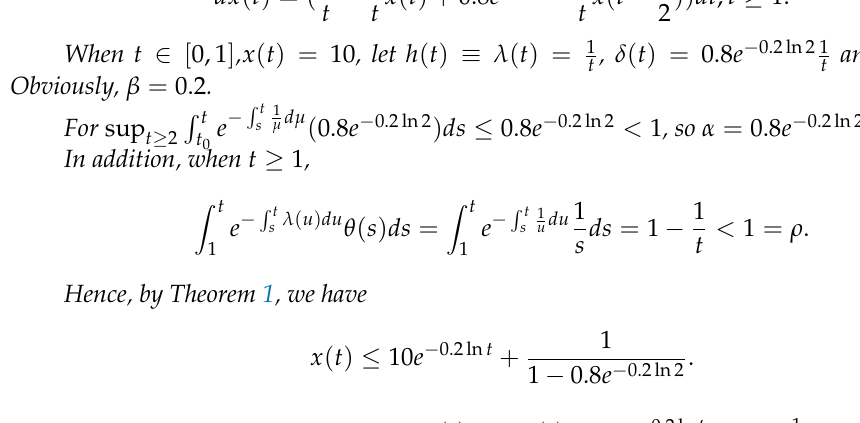
Figure 4 is the graph of function x ( t ) and y ( t ) = 10 e − 0.2ln t +